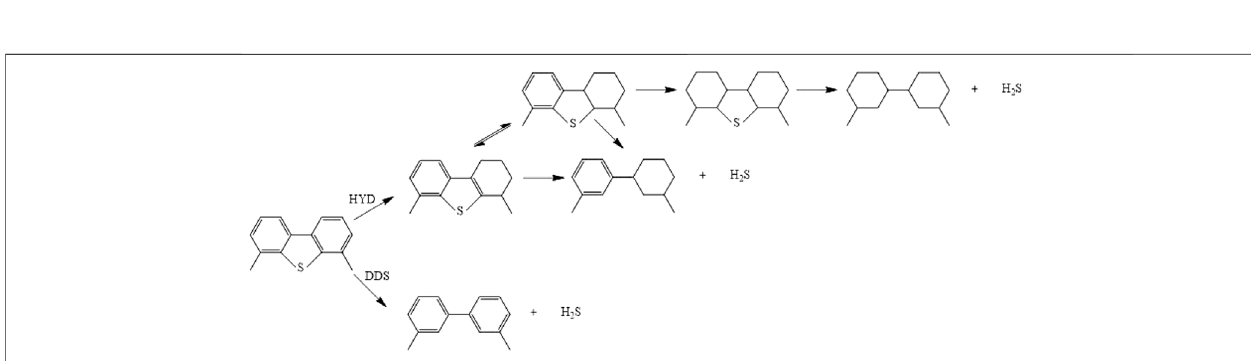
FIGURE5| CatalyticperformanceofimpregnatedGa-modi fi edNi – Mo/Al 2 O 3 : (A) 4,6-DMDBTconversionondifferentreactiontemperatures, (B) DDSselectivityof 4,6-DMDBT on different reaction temperatures, (C) 4,6-DMDBT conversion on different LHSVs at 280 ° C, and (D) DDS selectivity of4,6-DMDBTconversion on different LHSVs at 280 °